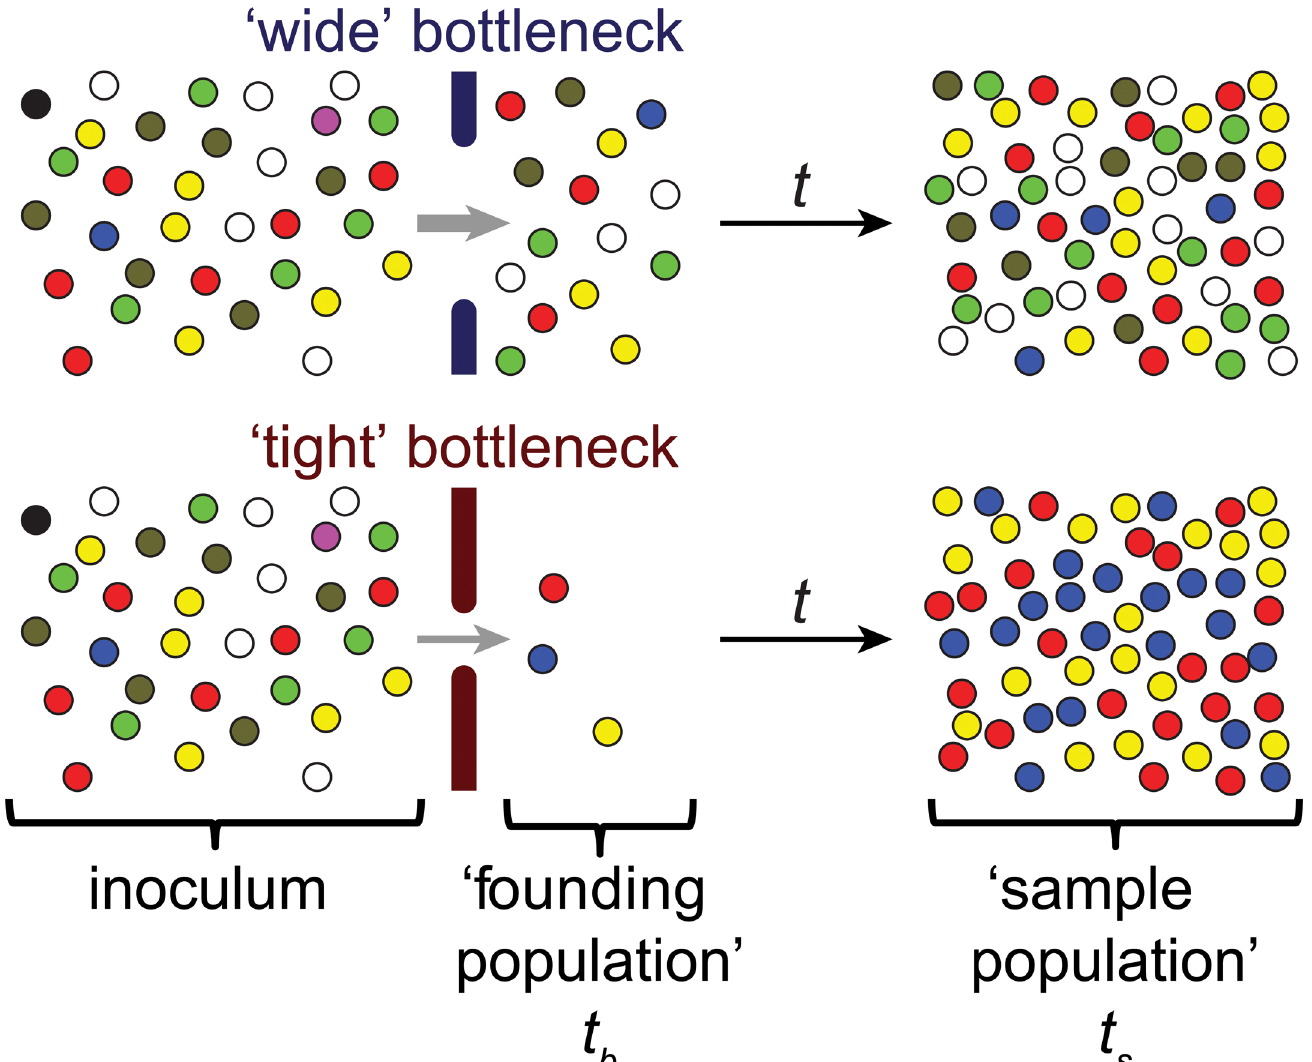
Fig 1. Schematic representation of the effect of bottlenecks on genetic diversity. Individual pathogens are shown as colored spheres; the colors represent distinguishable markers. The barriers to infection that constitute the bottleneck are shown by the solid bars and the size of the bottleneck is represented by the size of the gap between these bars. Bottlenecks are events that dramatically reduce the original population size, for example, the inoculum in infectious diseases. In the context of infection, the founding population consists of the pathogens that survive passage through the bottleneck and give rise to a population in a new environment, e.g., a new host or anatomical site. Often it is not feasible to sample directly after the bottleneck event ( t b ); instead, populations are sampled (at time t s ) after the passage of time (t), represented by the black arrow. During this time, the founding population often replicates. Wide bottlenecks lead to limited loss of markers (e.g., the magenta and black spheres) and limited changes in the marker frequencies (e.g., over- representation of the blue and under-representation of the olive marker). In contrast, tight bottlenecks lead to stochastic loss of many markers and substantial changes in marker frequencies. These changes can be used to determine the magnitude of bottleneck events and the size of the founding population, even after the population size has increased, provided that the expansion has limited effect on the marker composition (i.e., markers are fitness neutral, and no additional genetic drift